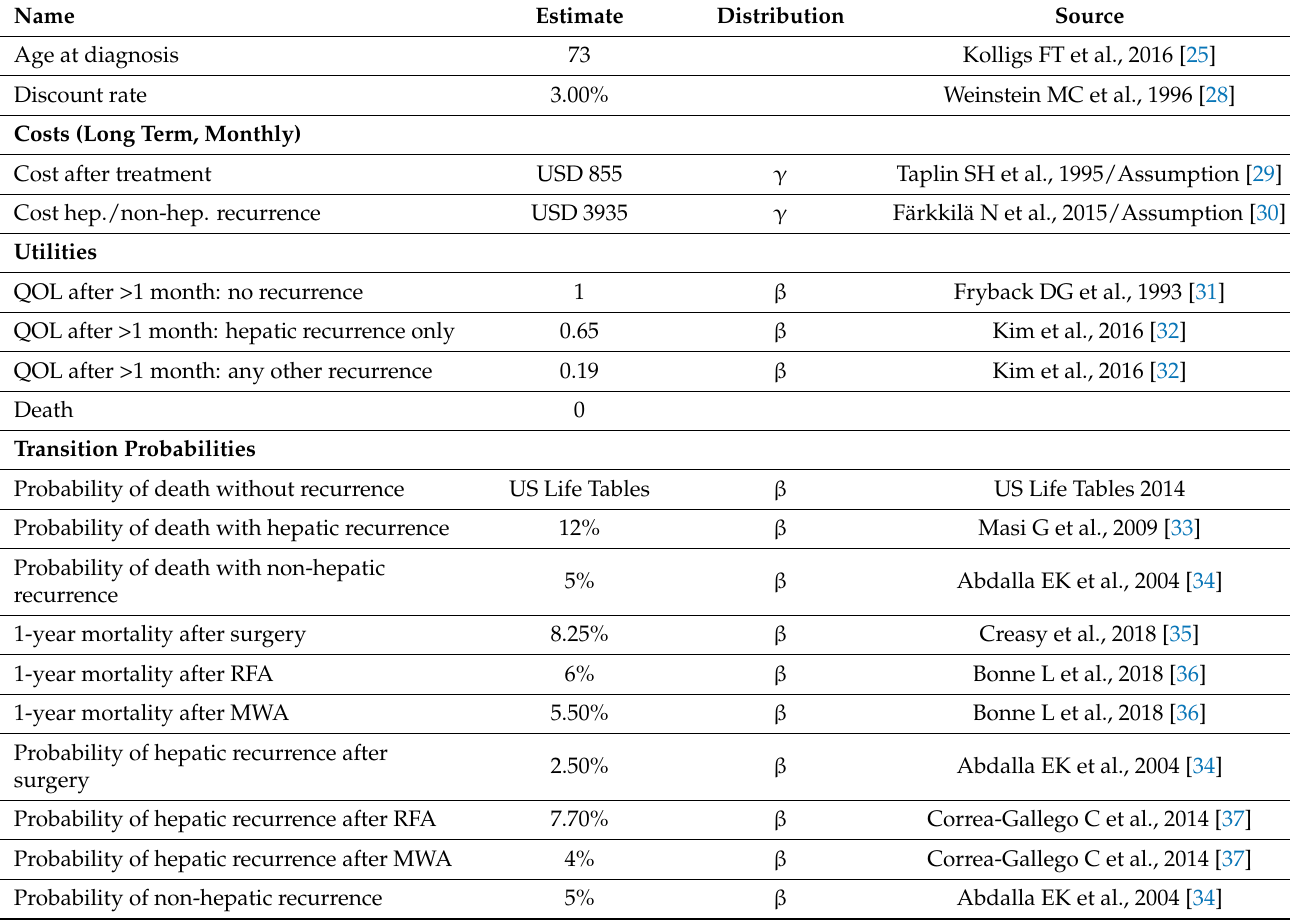
Table 2. Additional input parameters for long term costs and